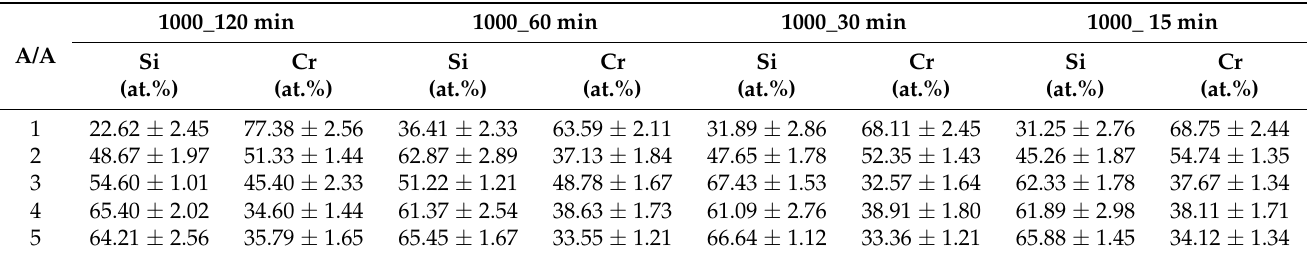
Table 3. EDS scannings of the chromized samples obtained by using 40 wt.% Cr in the pack mixture at 1000 ◦ C for 120 min, 60 min, 30 min, and 15 min.